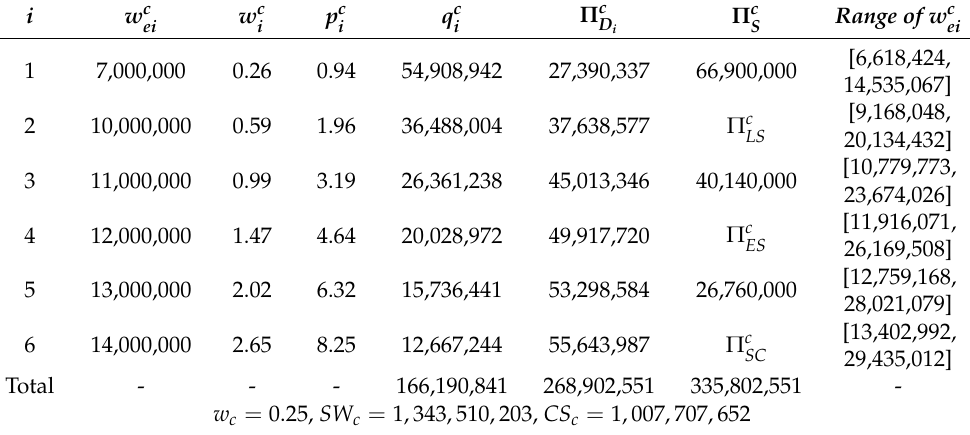
Table 5. Numerical Analysis Results of IBWT Supply Chain Coordination without Ramsey pricing.